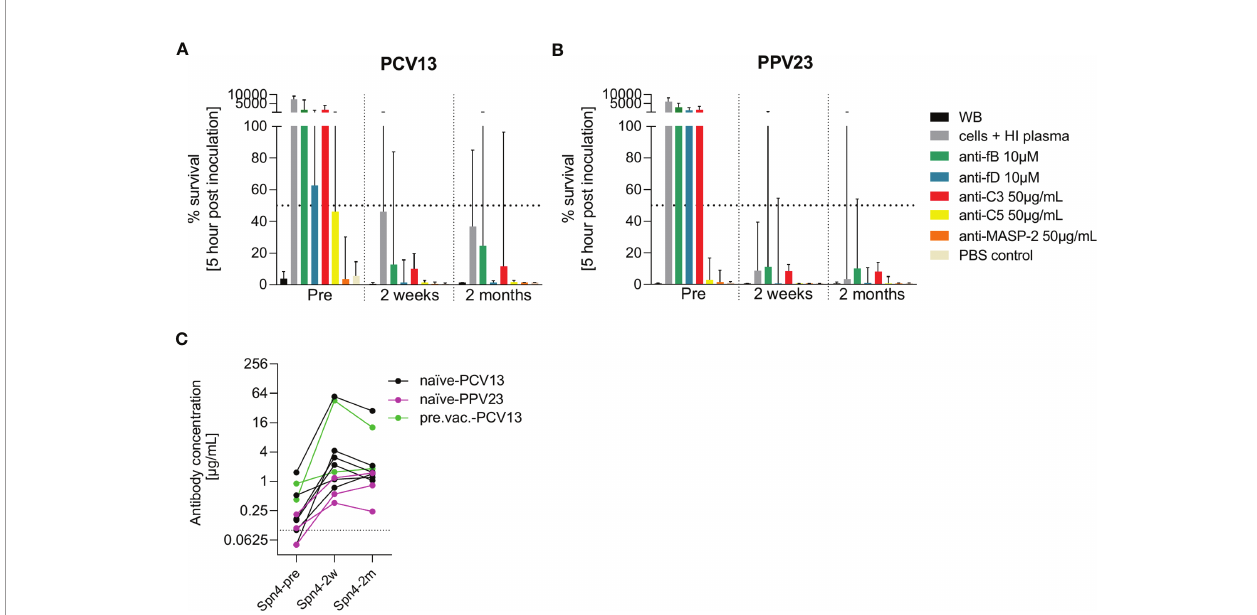
FIGURE 7 | Effect of PCV13 and PPV23 vaccination on bacterial opsonophagocytosis in the presence of complement inhibitors. The effect of pneumococcal vaccination on complement-dependent opsonophagocytosis was assessed in hirudin-anticoagulated whole blood. Cumulated results for eight PCV-13 vaccinated subjects (A) and three PPV23 vaccinated participants (B) are shown. Bars indicate the median percentage of surviving bacteria fi ve hours after inoculation. The dashed line represents 50% killing compared to the inoculum titer. Antibody concentrations in the serum of all study participants were measured before, two weeks and two months after vaccination by a pneumococcal IgG bioplex assays (C) . The dashed line in (C) represents the lower limit of quanti fi cation. PCV13: 13-valent pneumococcal conjugate vaccine; PPV23: 23-valent pneumococcal polysaccharide vaccine; WB: whole blood, HI: